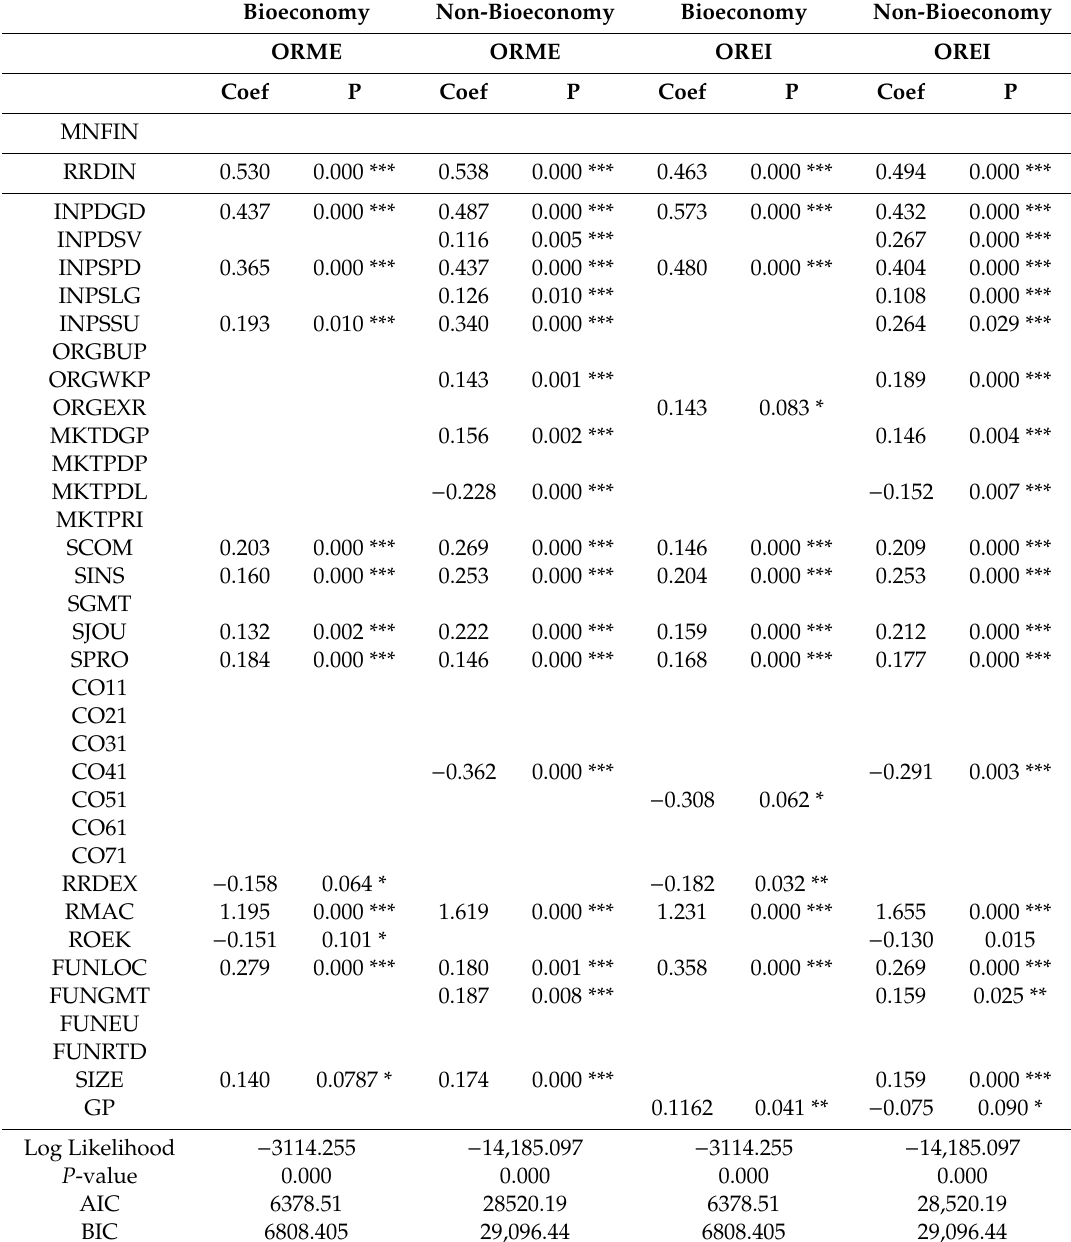
Table A6. Estimation results of multivariate tobit model